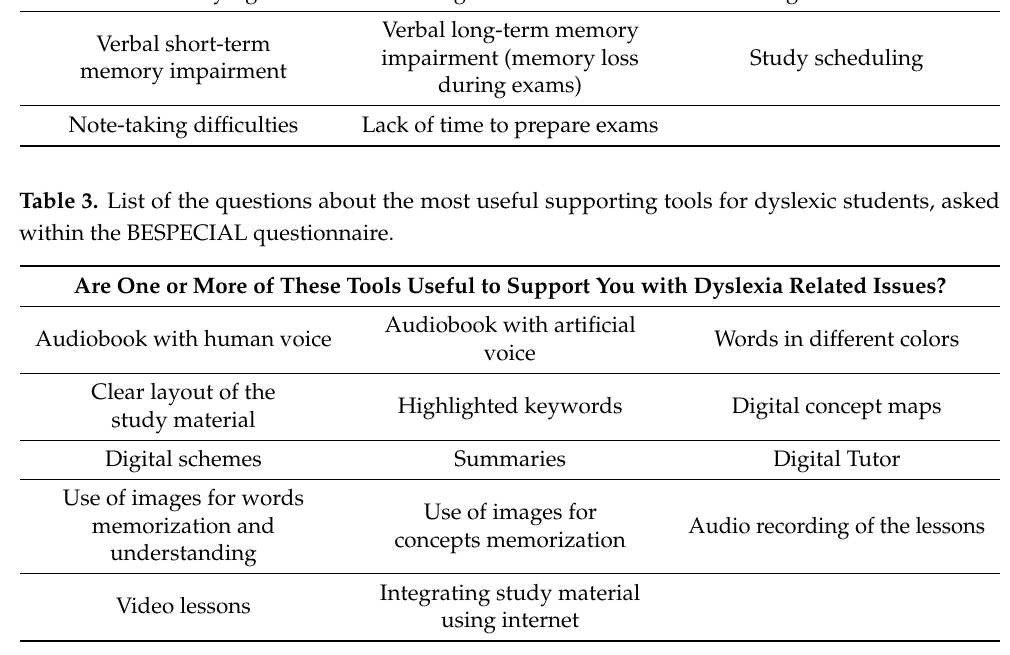
Table 4. List of the questions about the most useful supporting strategies for dyslexic students, asked within the BESPECIAL